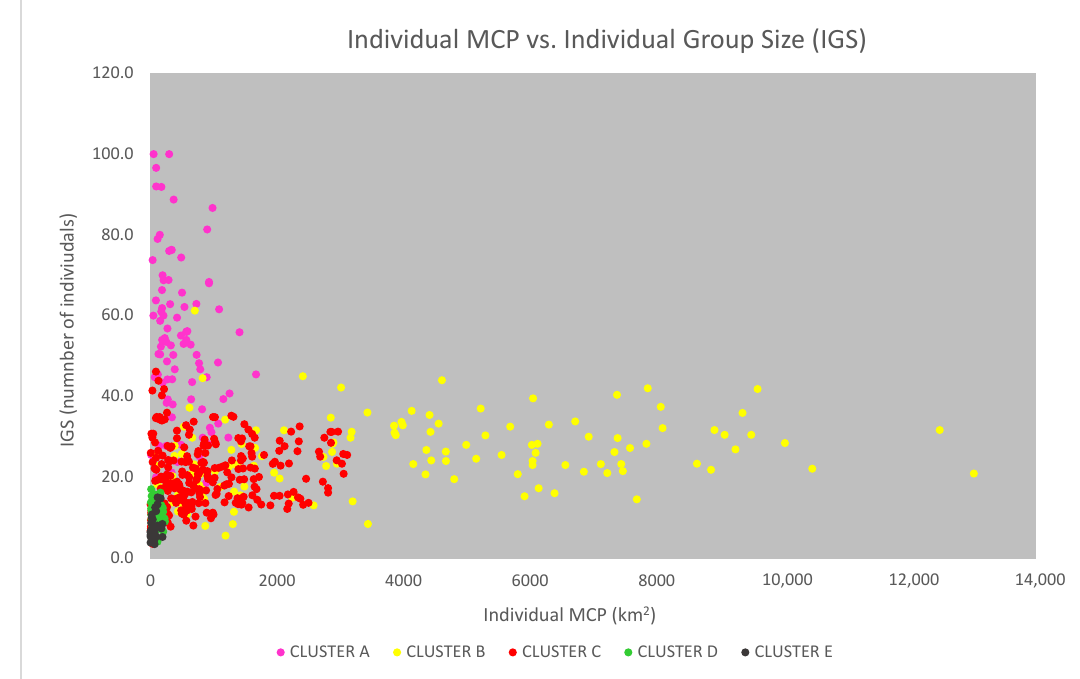
Figure 11. The individual MCPs are displayed in the scatterplot against the individual group size (IGS). The colour of the points indicates the cluster to which they belong (the data from the cluster F—Gulf of Ambracia—were not available for this analysis).